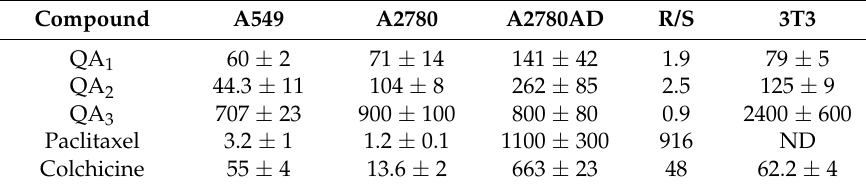
Table 1. Anti-proliferative effect of quinolin-6-yloxyacetamides in A2780, A2780AD, A549, and 3T3 cells.